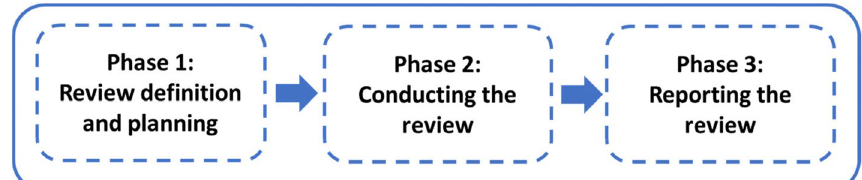
Fig. 2 Phases of SLR protocol [39,